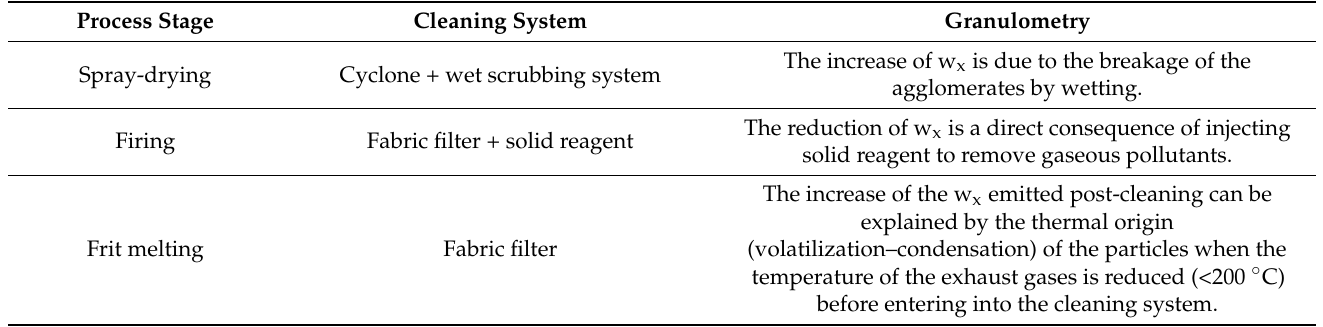
Table 9. Comments about w x associated with different ceramic process stages and cleaning sys- tems.